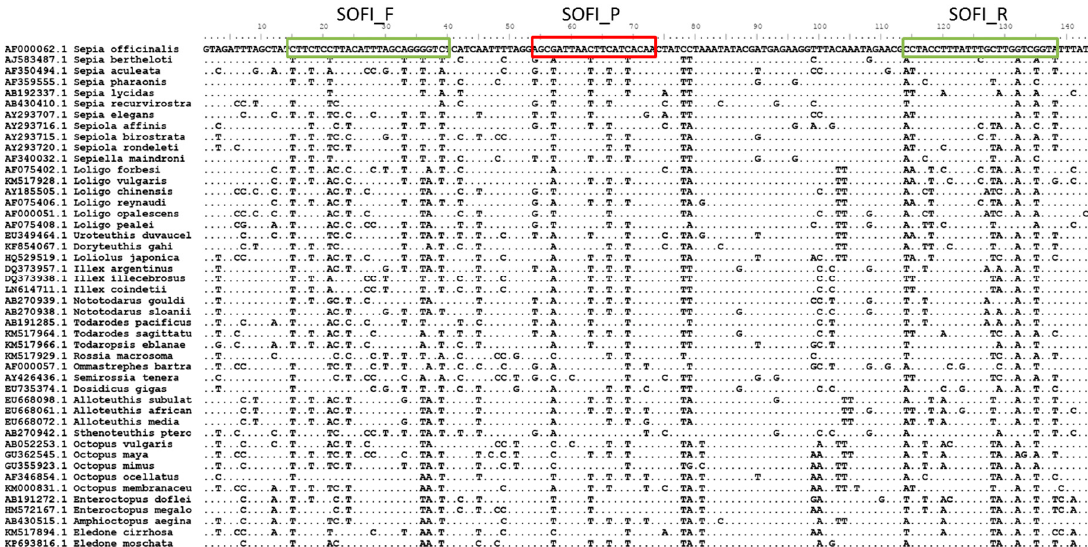
Figure 1. Multiple sequence alignment of the mitochondrial COI (Cytochrome Oxidase I) fragment, showing the position of the primers and probe designed.